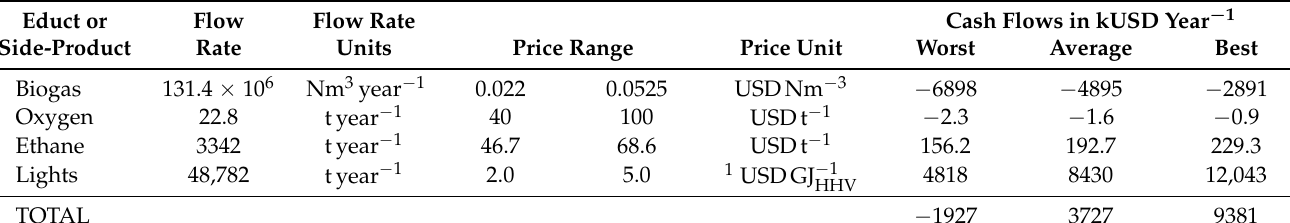
Table 3. Summary of all educts and side products of the Bio-OCM